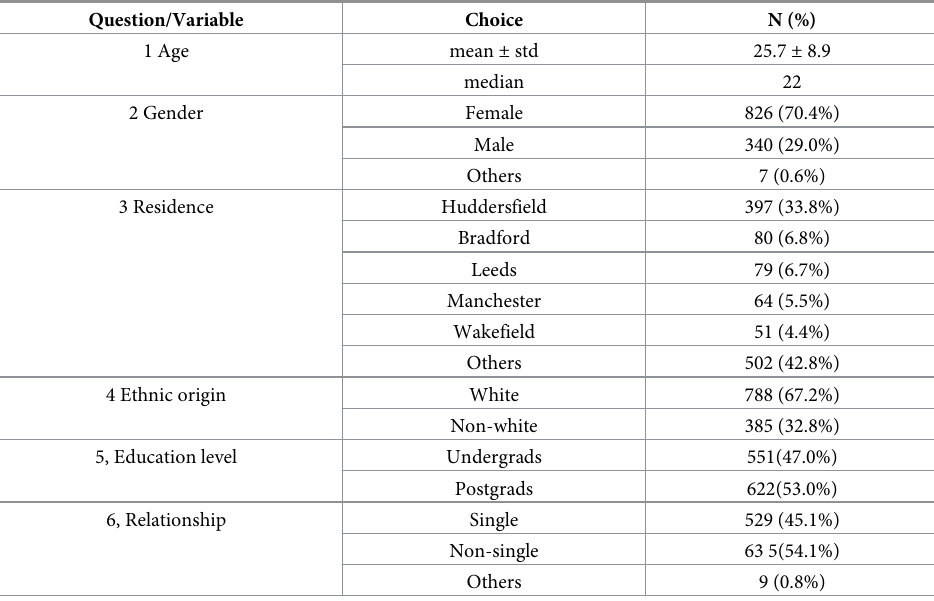
Table 1. Demographics descriptive analysis.